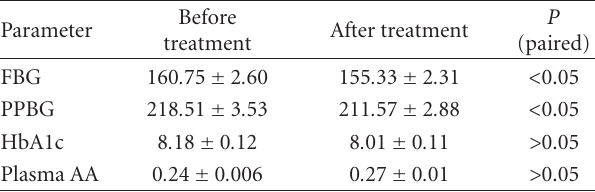
Table 2: E ff ect of metformin with placebo on FBG, PPBG, HbA1c, and plasma AA in patients with type 2 diabetes mellitus after 12 weeks of treatment.